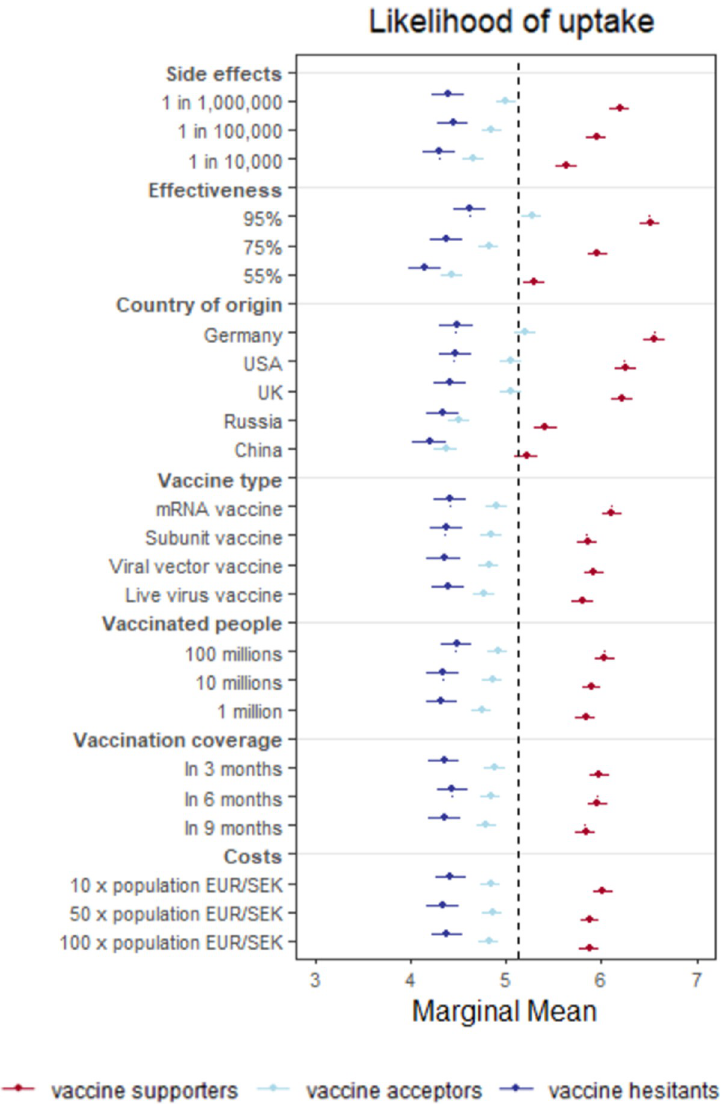
Fig 3. Subgroup analysis: Differences across different vaccine hesitant groups. Each dot and error bar represents the MM (and its 95% CI) of vaccine attributes on self-reported likelihood of uptake for the three groups of people with varying vaccine attitudes. The dashed line represents the grand